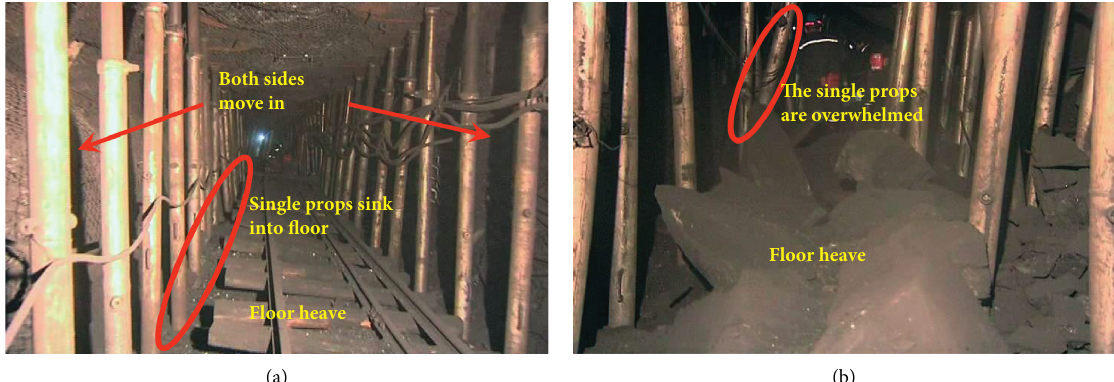
Figure. 3: Deformation of the gob-side roadway under overlying coal pillars: (a) the slight deformation area of the roadway and (b) the serious deformation area of the roadway.